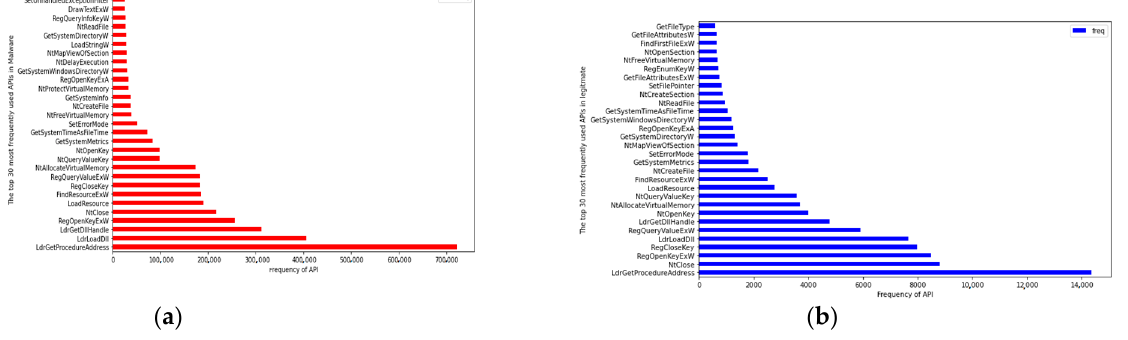
Figure 3. The top 30 API requests that are used the most: ( a ) Malware class; ( b ) legitimate class. Table 2. The unique API calls in each class (out of